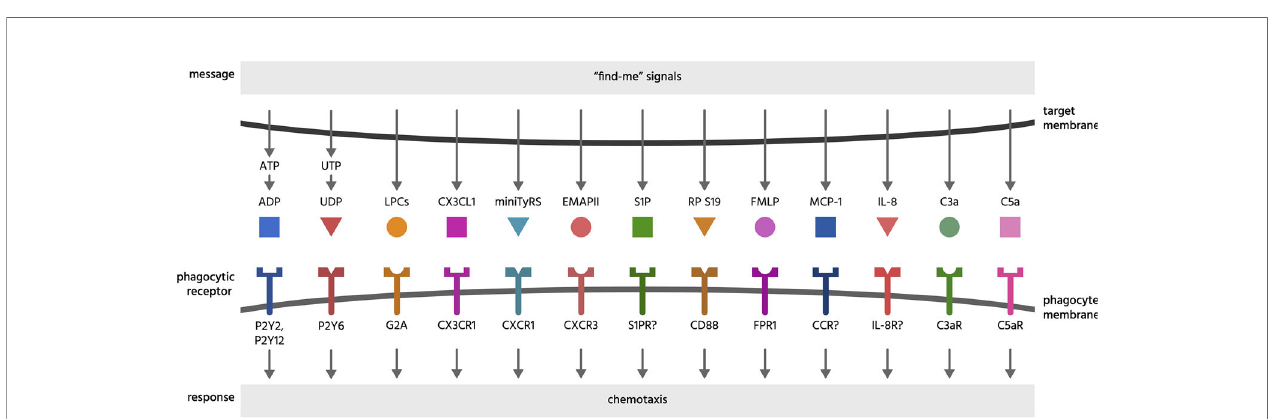
FIGURE 1 | Find-me signals and their receptors. Find-me signals are molecules released from a cell to attract phagocytes, resulting in phagocytosis of that cell. The fi gure illustrates fi nd-me signals released from mammalian target cells, and their putative receptors on phagocytes, mediating the recruitment of phagocytes to the target cells. ADP, adenosine-5 ’ -diphosphate; ATP, adenosine-5 ’ -triphosphate; C3a, complement component C3a; C5a, complement component C5a; C3aR, C3a receptor; C5aR, C5a receptor (CD88); CCR, chemokine receptor; CD88, cluster of differentiation 88 (a complement component C5a receptor); CX3CL1, chemokine C-X3-C ligand 1 (fractalkine); CX3CR1, C-X3-C chemokine receptor; CXCR1, C-X-C chemokine receptor type 1; CXCR3, C-X-C chemokine receptor type 3; EMAP II, endothelial monocyte-activating polypeptide II; FMLP, N-formylmethionyl-leucyl-phenylalanine; FPR1, formyl peptide receptor 1; G2A, G protein coupled